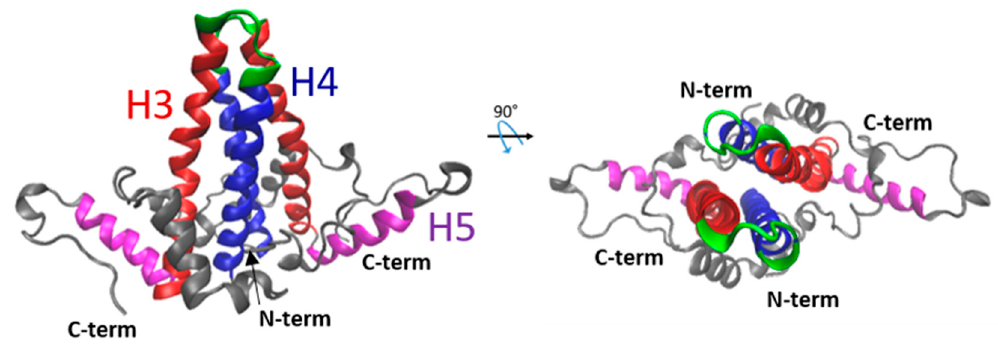
Figure 3. Representation of the 3D structure of the HBc–NTD dimer. Two orthogonal views of the HBc dimer are shown. This dimer structure was obtained from the Protein Data Bank (PDB) 1QGT [24]. Each monomer is formed of five α -helices. Helices 3 (red) and 4 (blue) display a hairpin shape assembling into a four-helical bundle within the dimer, generating the capsid spikes of the particle. The spike tip (in green) corresponds to the highly immunogenic c / e1 epitope [23]. The fifth helix (magenta) and the downstream proline-rich loop are involved in the dimer–dimer oligomerization.